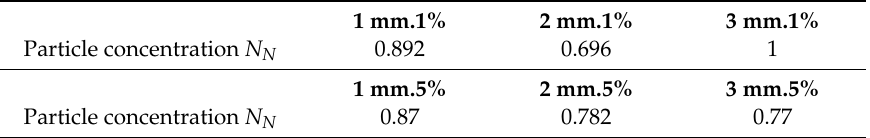
Table 6. Particle concentration NN on Section